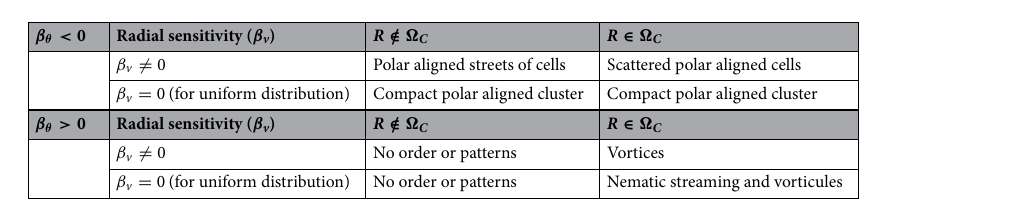
Figure 3. Simulation snapshots of the velocity field at long times. Arrows show the direction and magnitude of the velocity field. The snapshots were taken after 1000 time steps. 1000 particles were simulated, with an interaction radius of 3, and noise standard deviation of angles and speeds equal to 0.01. Here g = 1, β v = − 5 and ε = 0 . In ( a ) the value of the angular sensitivity was equal to 18 while in ( b ) the angular sensitivity was equal to − 0.25 . Periodic boundaries were employed.